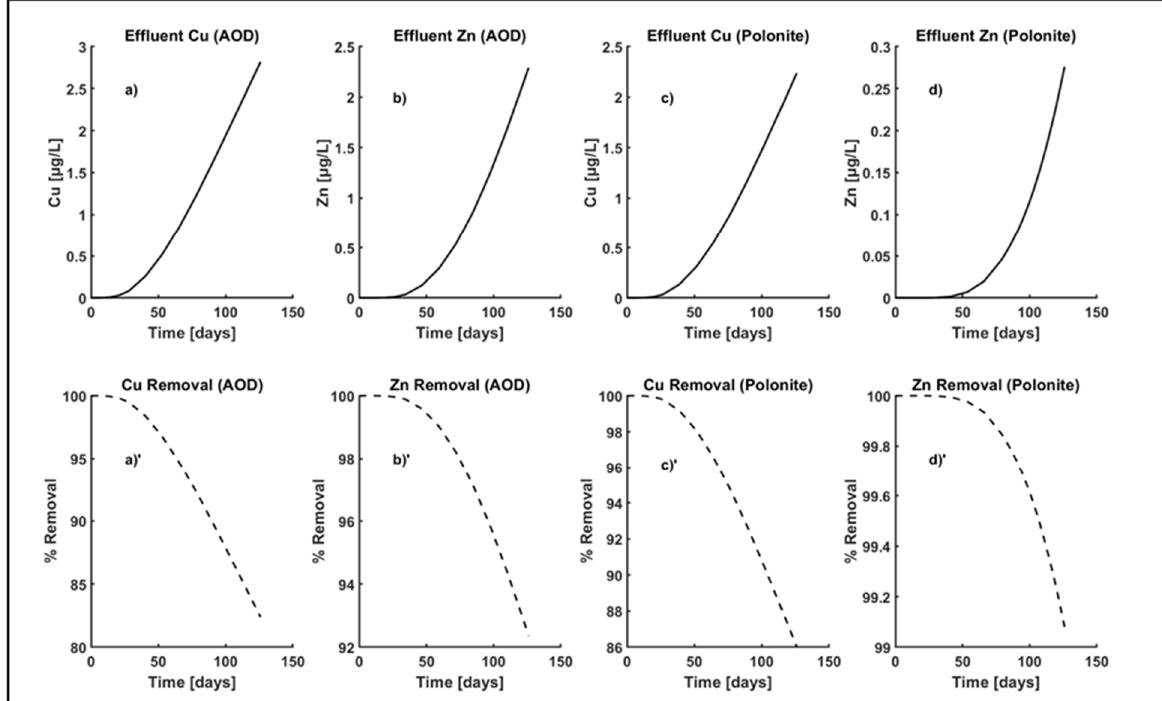
Figure 4. Transient state and percentage removal of the concentration of Cu and Zn in the PBR according to the modelling response. ( a )’, ( b )’, ( c )’, and ( d )’ correspond to the percentage removal of ( a ), ( b ), ( c ), and ( d ), respectively.